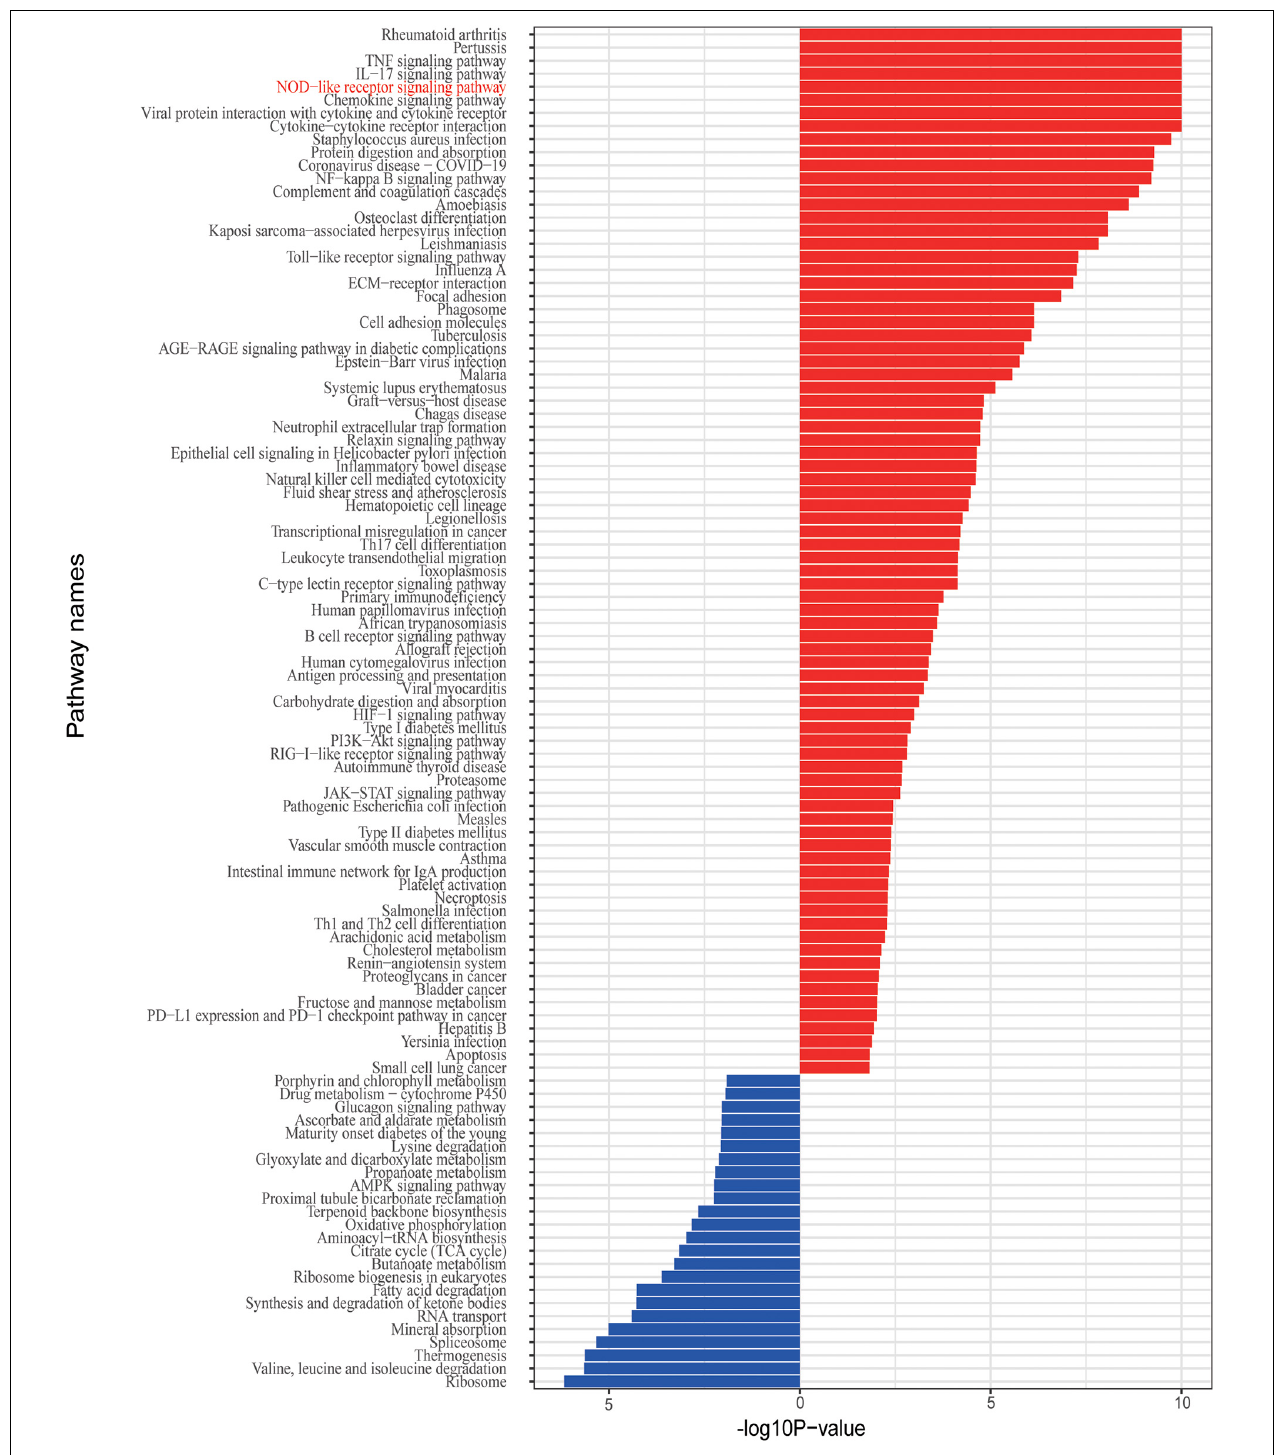
FIGURE 3 | Enriched functional pathway associated with the DEGs.